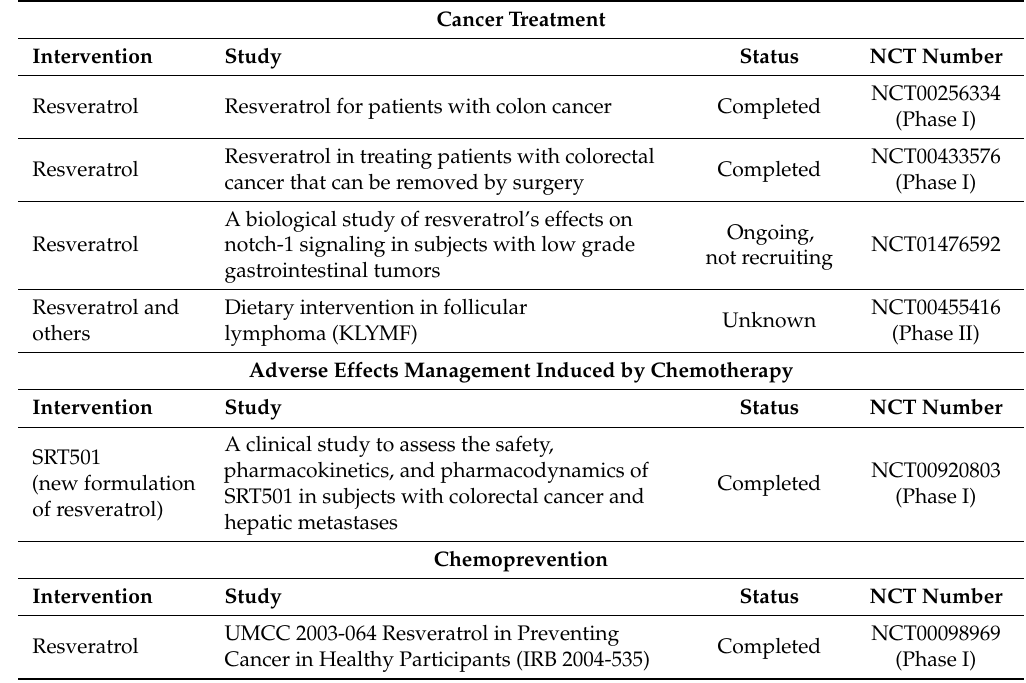
Table 8. Human studies using resveratrol in